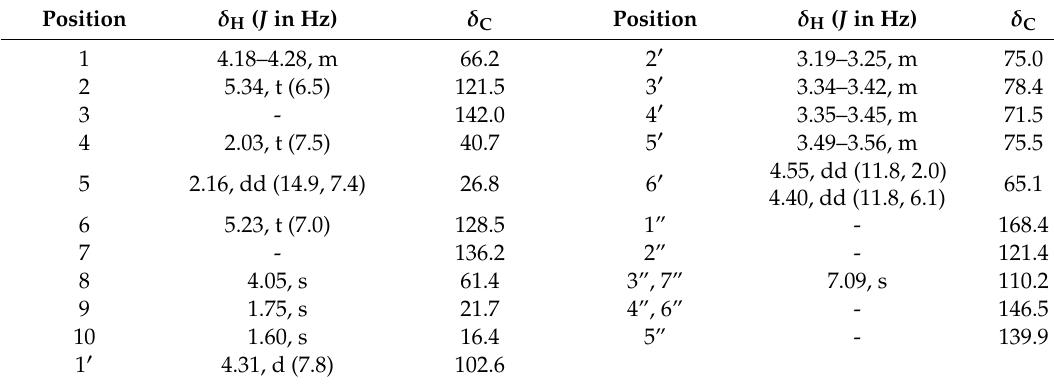
Table 1. 1 H- and 13 C-NMR spectral data of 1